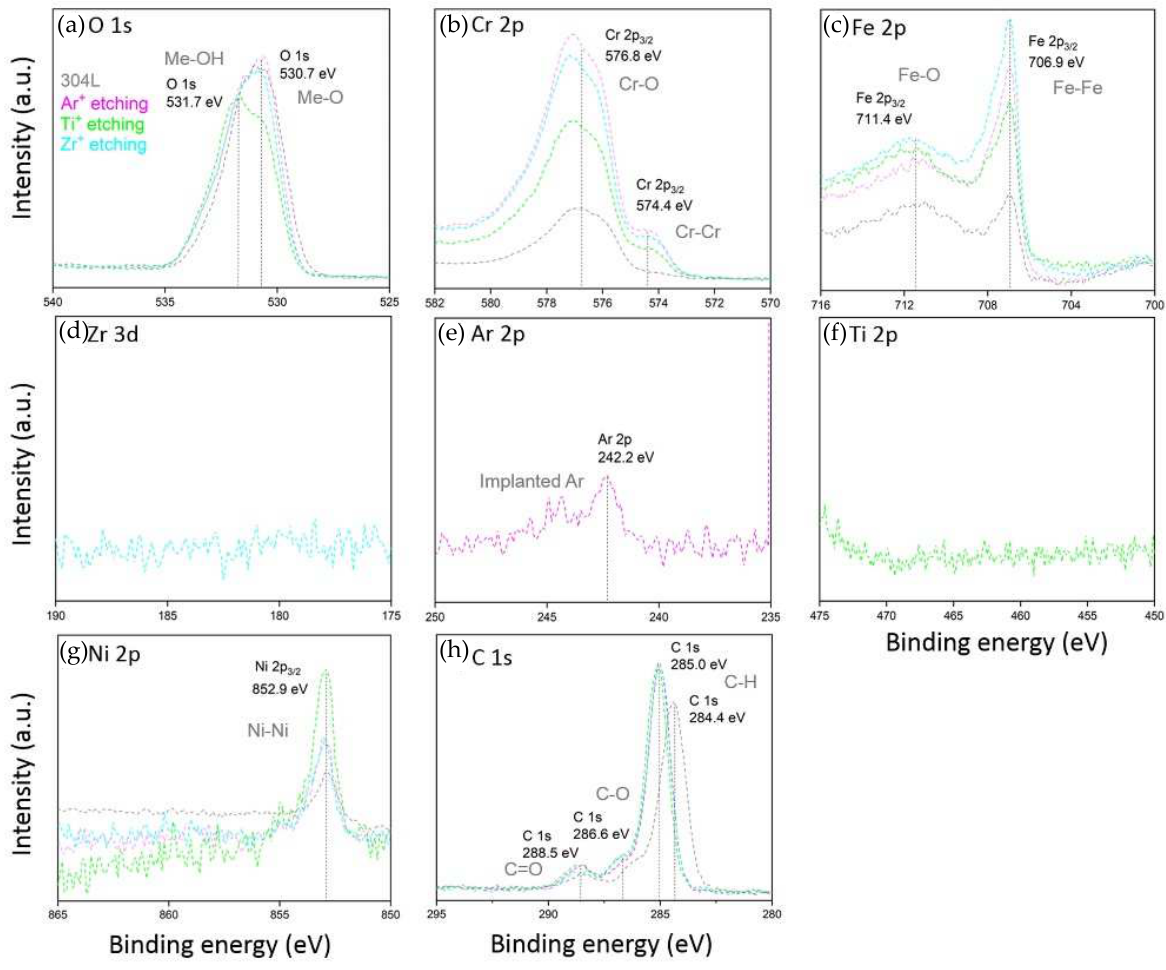
Figure 10. High-resolution XPS spectra of ( a ) O 1s, ( b ) Cr 2p 3/2 , ( c ) Fe 2p 3/2 , ( d ) Zr 3d, ( e ) Ar 2p, ( f ) Ti 2p, ( g ) Ni 2p and ( h ) C 1s of raw and etched 304L steel after 48 h in nitric acid solution at boiling temperature.